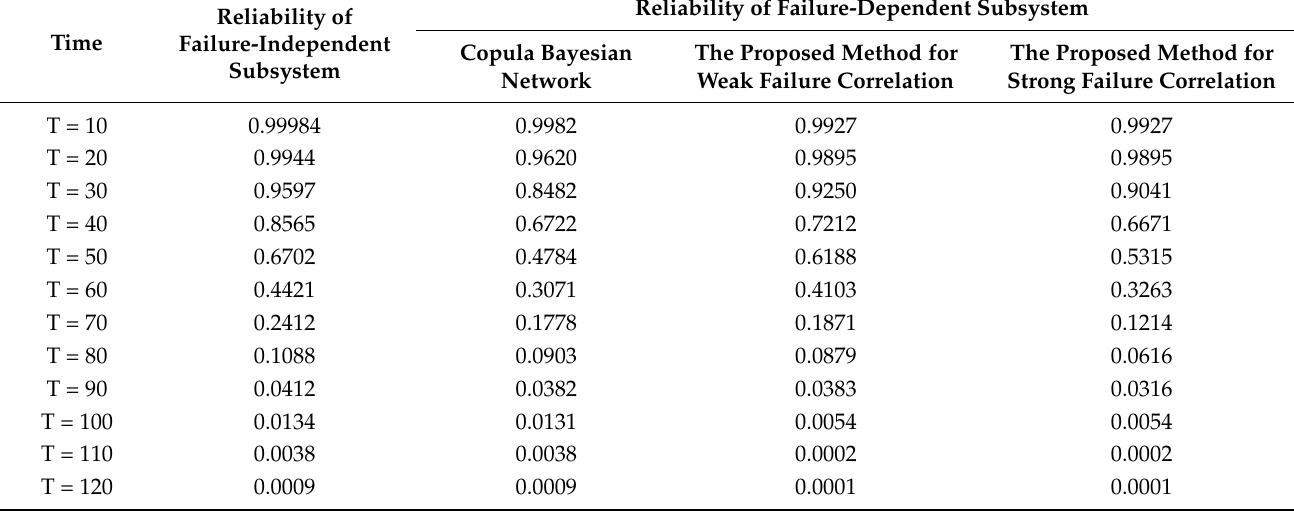
Table 11. Comparison of subsystem reliability of Machine pair 5–6.